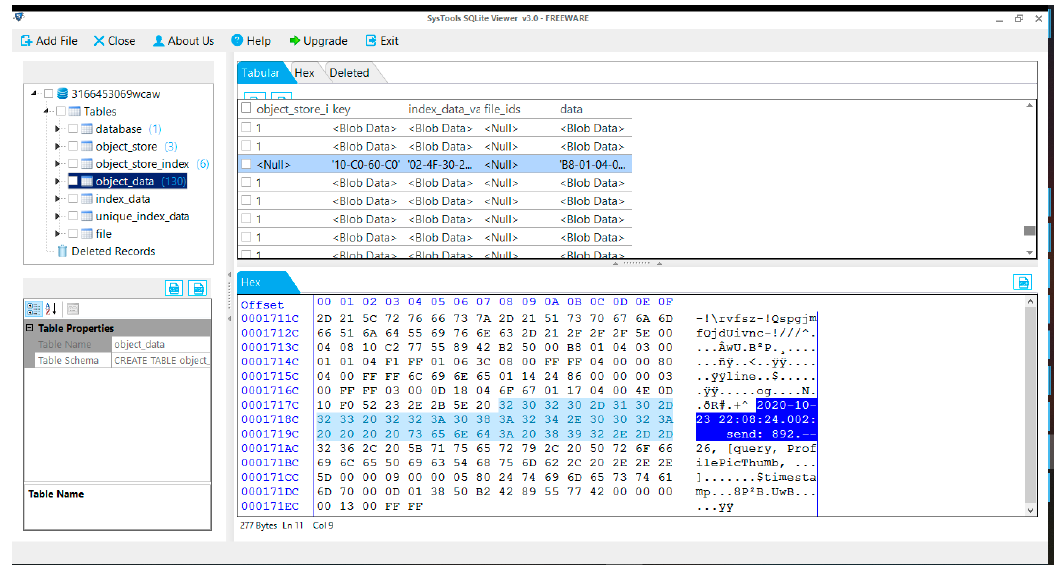
Figure 2. SQLite Browser Displaying Mozilla Firefox IndexedDB SQLite File.